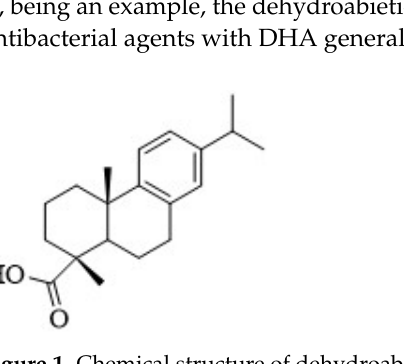
Figure 1. Chemical structure of dehydroabietic acid (DHA). Antimicrobial diterpenes like DHA target cellular membranes by a combination of hydrophobic and electrostatic adsorption effects at the membrane/water interface, leading to membrane destabilization and enhanced permeability. Subsequently, disruption of the physical integrity of the membrane or translocation into the cell occurs, compromising cellular processes such as DNA replication, protein folding and synthesis. This mode of action has been shown to limit the risk of cross-resistance